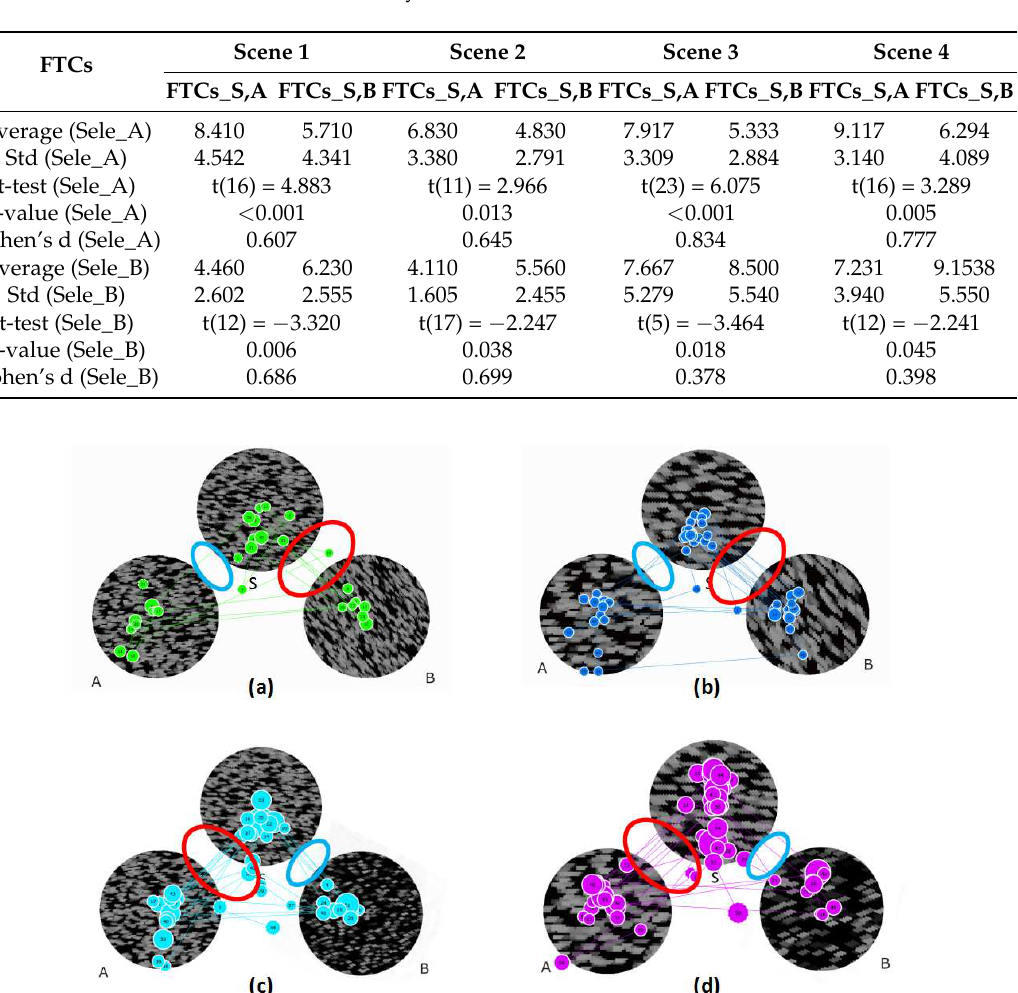
Table 3. Statistical analysis of FTCs for four scenes in both tests.